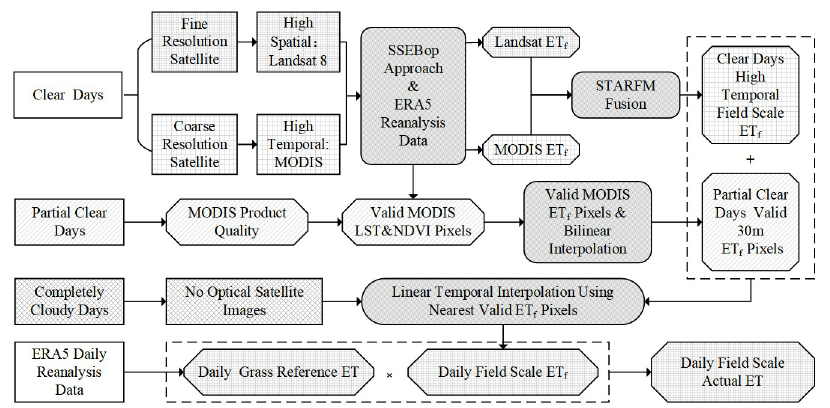
Fig 2. Flowchart of the enhanced approach for generating daily field-scale ET using SSEBop by MODIS and Landsat data.